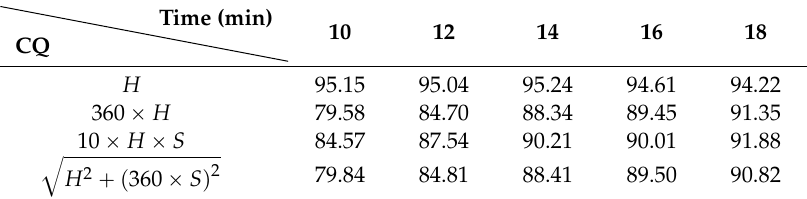
Table 3. Linear coefficient between characteristic quantities and concentration of HCG (%).